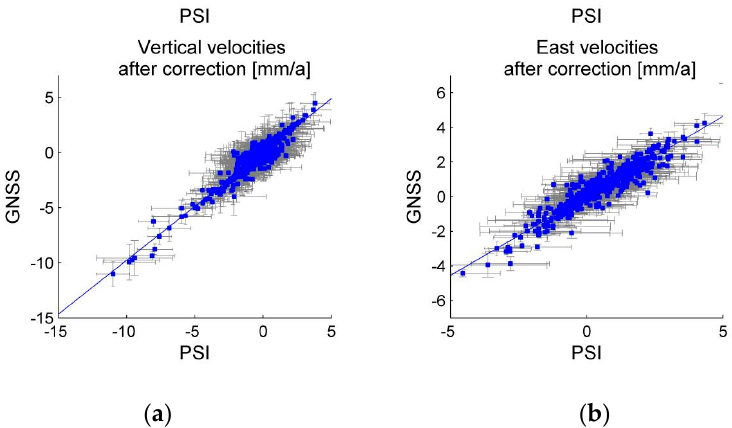
Figure 6. Comparison between GNSS and SAR velocity components after the correction v PSICorr (vertical— a , east— b ) calculated for each GNSS site. The Pearson coefficients (blue lines) after the correction changed from 0.19 to 0.95 for the vertical component ( a ) and from 0.028 to 0.94 for the east component ( b ).